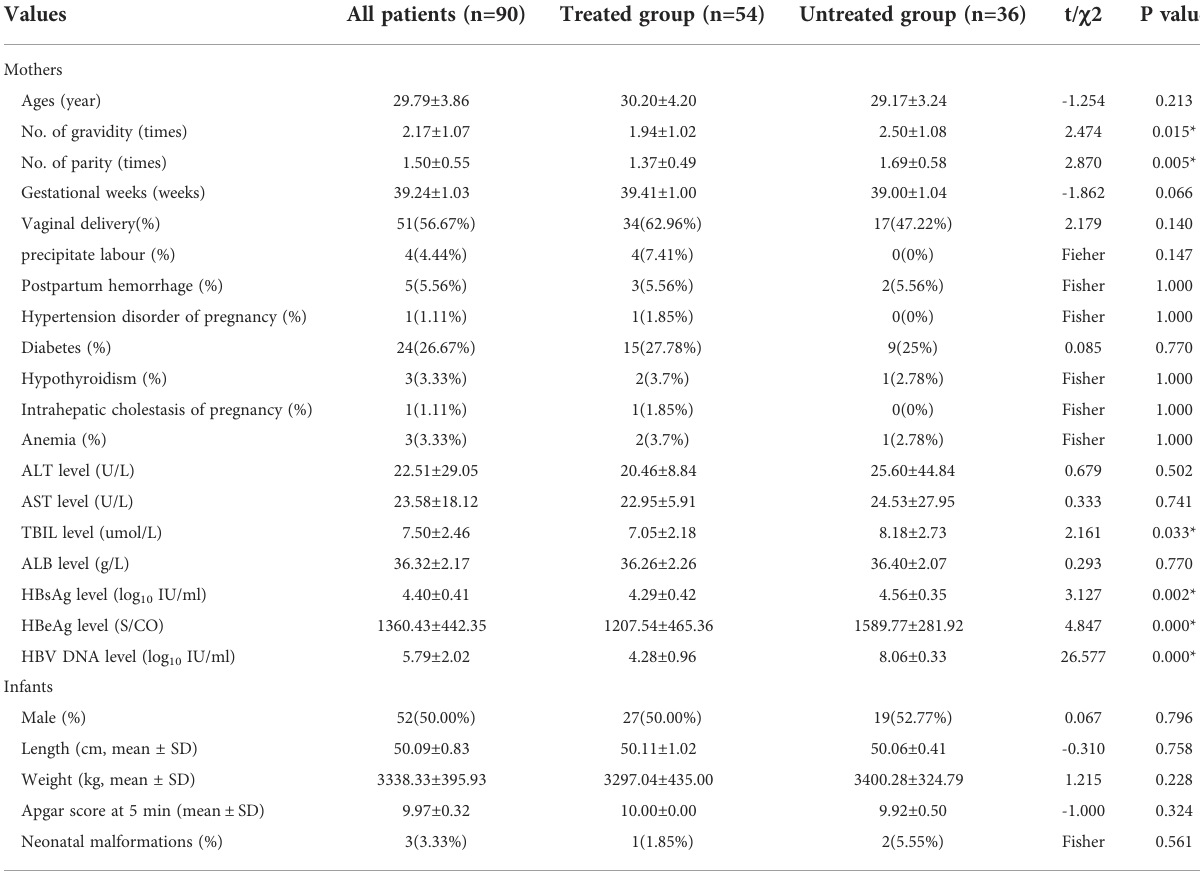
TABLE 1 Basic characteristics of the